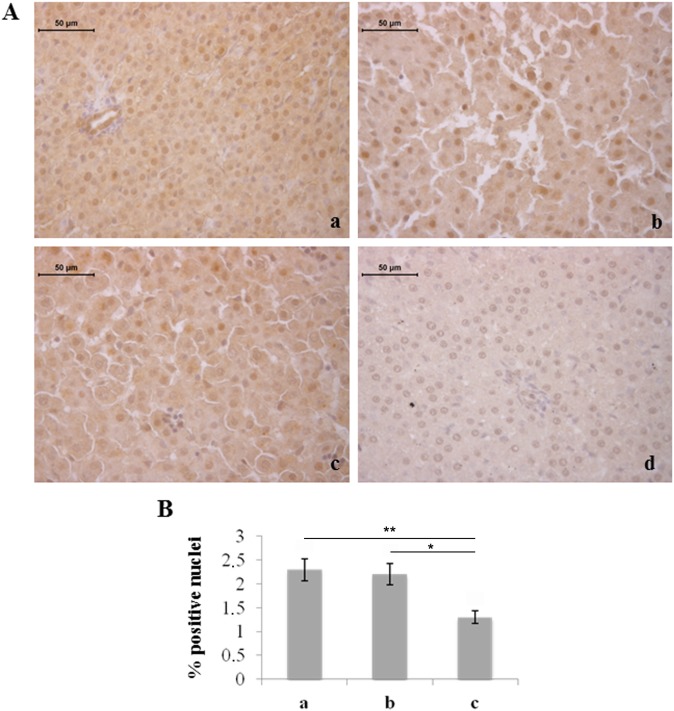
Severe hyperoxia decreases the number of hepatocytes immunostained for VEGF.A) Immunohistochemical detection of VEGF expression in neonatal rat livers exposed to moderate and severe hyperoxia. a) ambient air; b) 60% hyperoxia; c) 95% hyperoxia; d) negative control; scale bar: 50 µm, magnification 40x. B) Graphic representation of the percentage of VEGF positive nuclei (±SD); densitometric analysis determined by direct visual counting of ten fields for each of three slides per sample. * = p<0.05; ** = p<0.01.